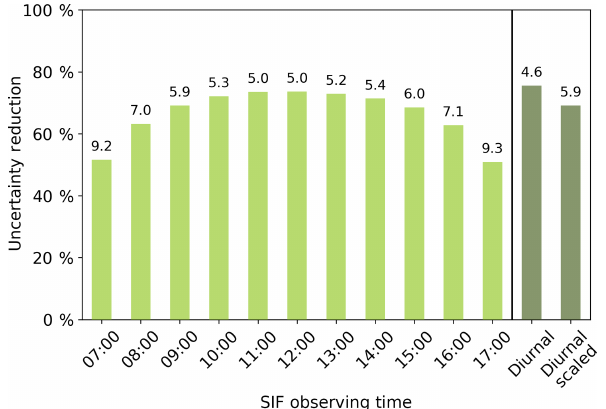
Figure 8. Effective constraint on global annual GPP for different observing times and the two diurnal cycle configurations. Values at the top of the bars correspond to the posterior uncertainty ( σ ) in global annual GPP.